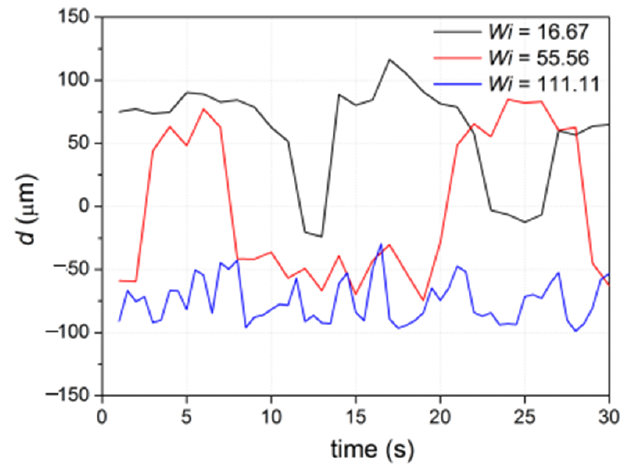
Figure 8. The edge length of the forward-flowing streamline on the left side of the flow. To verify whether the above instability was elastic-related, we injected Newtonian fluid into the nozzle–square microchannel for comparison. Here, a glycerol solution of 80% volume concentration is used. The flow rate was set to Q = 2000 µ L/h, corresponding to an Re number of 0.07. As shown in Figure 9a,b, the forward flow and backward flow of the glycerol solution were both symmetric and steady, and both flow patterns were almost the same. This verifies that the asymmetric flow pattern, the unsteady streamline, and the flow direction-dependent instability of the PAM solution were due to the fluid elastic property.